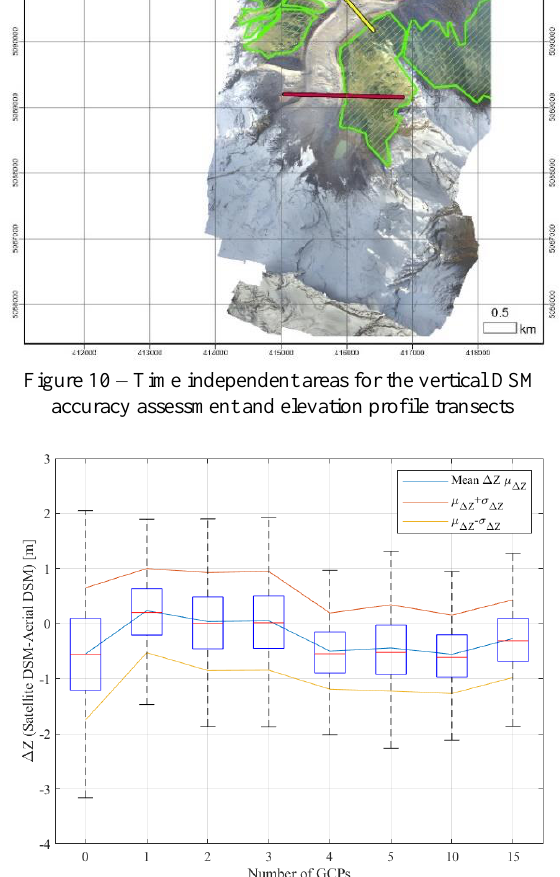
Figure 11 – DSM elevation accuracy: trend of  Z (over >21M height control points) vs number of GCPs of Table 2